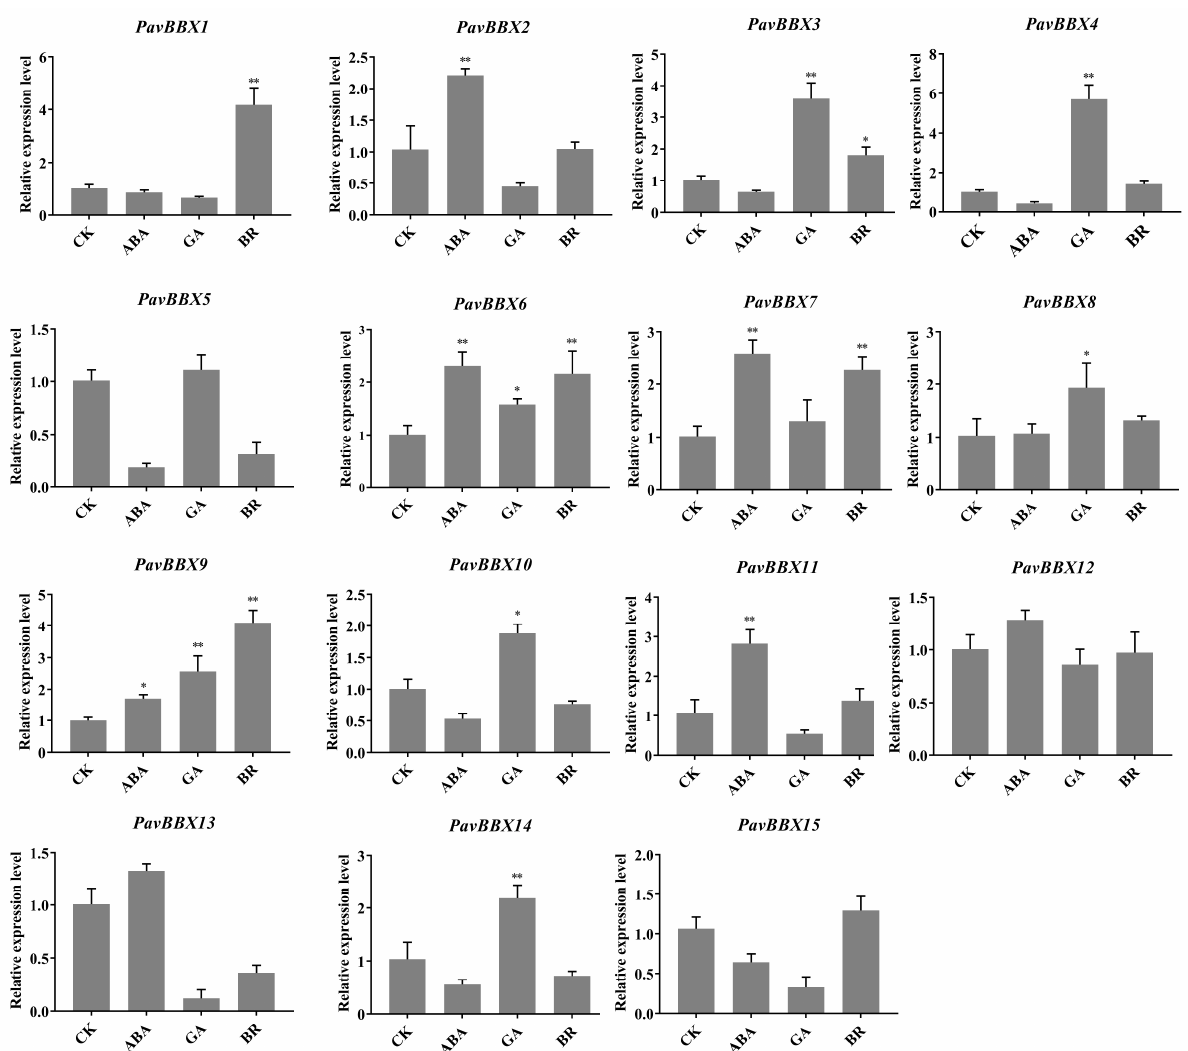
Figure 8. Expression profiles of sweet cherry BBX genes in response to ABA, GA, and BR treatment. PavActin was used as the internal reference control to normalize template levels. Relative mRNA levels are represented as the mean ± SD (n = 3). Statistically significant differences were assessed using Student’s t -test (* p < 0.05, ** p < 0.01).